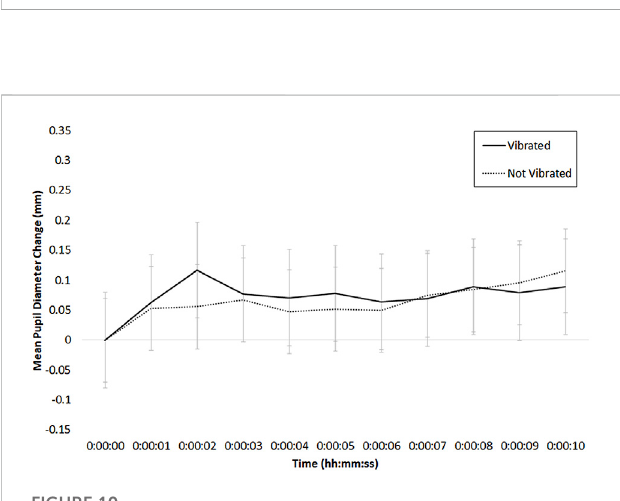
FIGURE 10 Mean phasic change in pupil diameter (in mm) during the vibrate